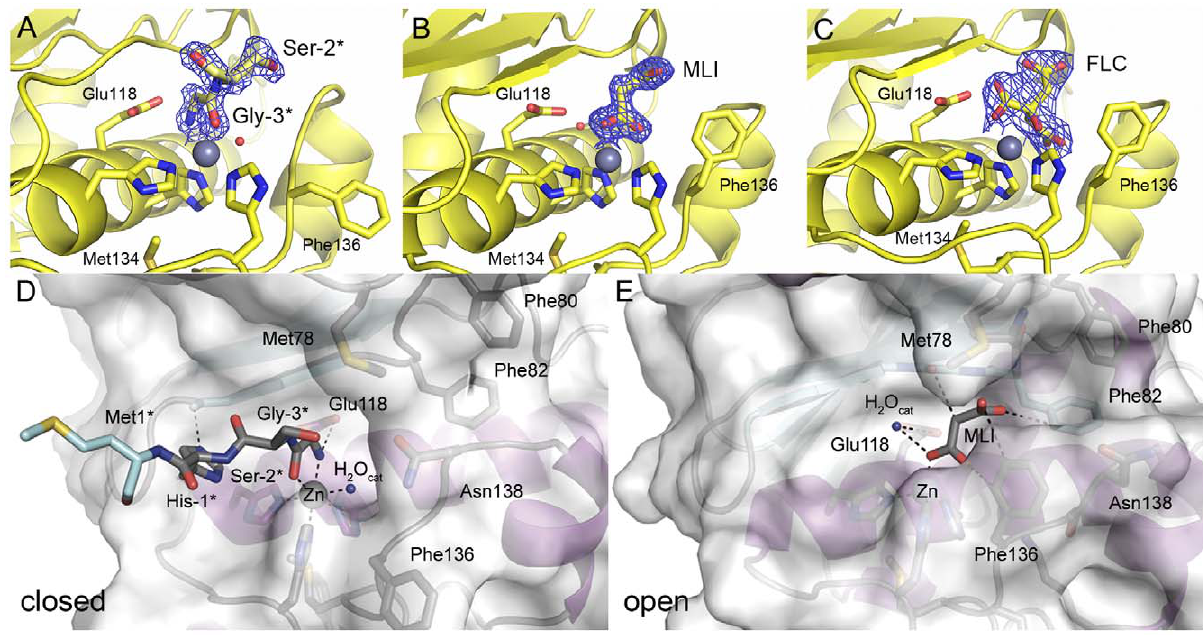
Figure 4. Structural differences between NHis- Af AmzA and nat- Af AmzA. Simulated annealing F o –F c omit map of (A) the N-terminus of a symmetry-related molecule (Gly-3*-Ser-2*) in NHis- Af AmzA, (B) a malonate molecule (MLI) in nat- Af AmzA::malonate and (C) a citrate molecule (FLC) in nat- Af AmzA::citrate, contoured at 2 s level. The maps were generated using phenix.omit_map [37] and converted to the ccp4 format with FFT (V6.1) [32]. Important residues are shown as sticks. The zinc ions and water molecules are shown as grey and red spheres, respectively. (D) Surface representation of NHis- Af AmzA active site cleft with the N-terminus of a symmetry related molecule bound to the catalytic zinc ion (primed site in closed conformation). (E) Surface representation of nat- Af AmzA active site cleft with the zinc-bound malonate molecule (MLI; primed site in open conformation). Important residues and the catalytic water molecule (H 2 O cat ) are labeled. The surface is transparent to allow a view on the residues involved in zinc ion and ligand